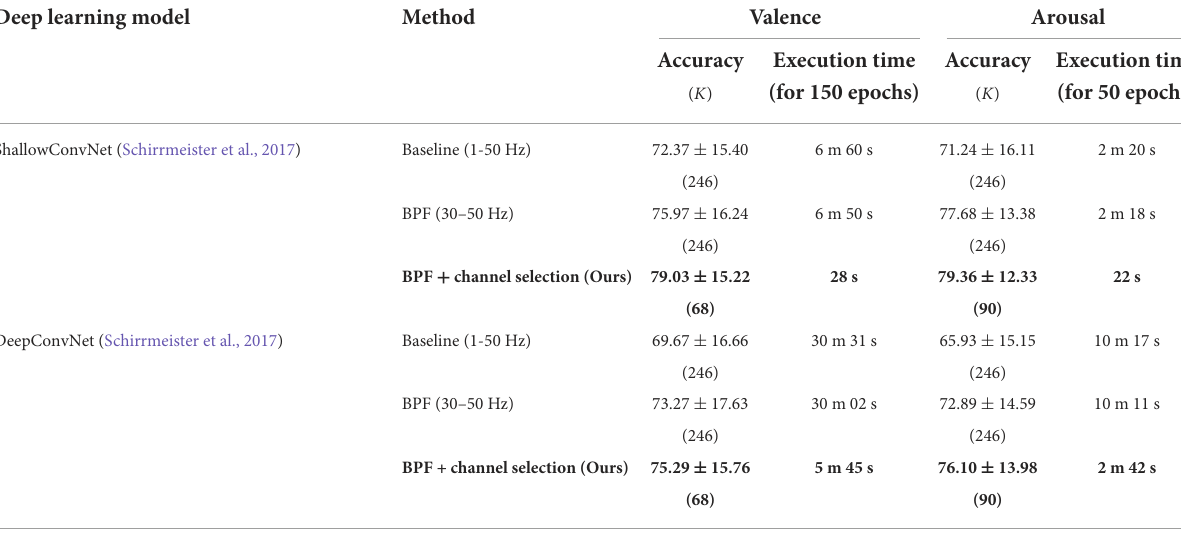
TABLE 7 Performance of the proposed framework in terms of average accuracy (%) and execution time.